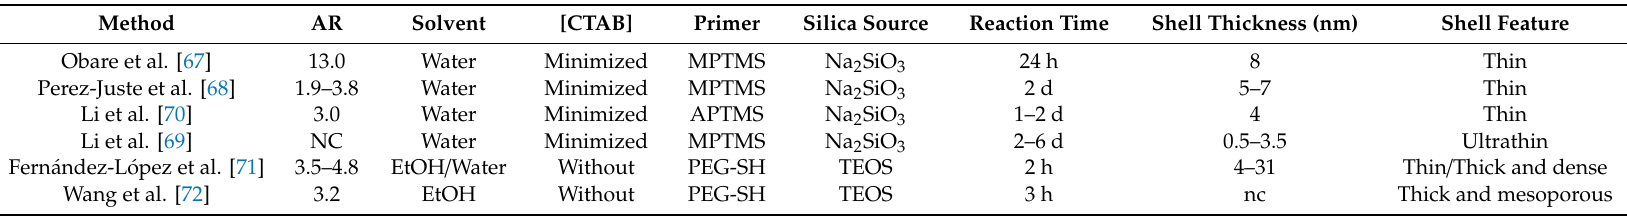
Table 1. Summary of the reaction conditions for silica coating on AuNRs using a surface primer exchanged with CTAB and respective silica shell aspects.